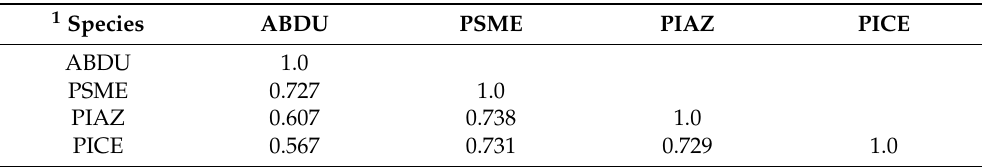
Table 4. The correlation matrix is presented for the regional average ring-width chronologies based on four conifer species for the common period of